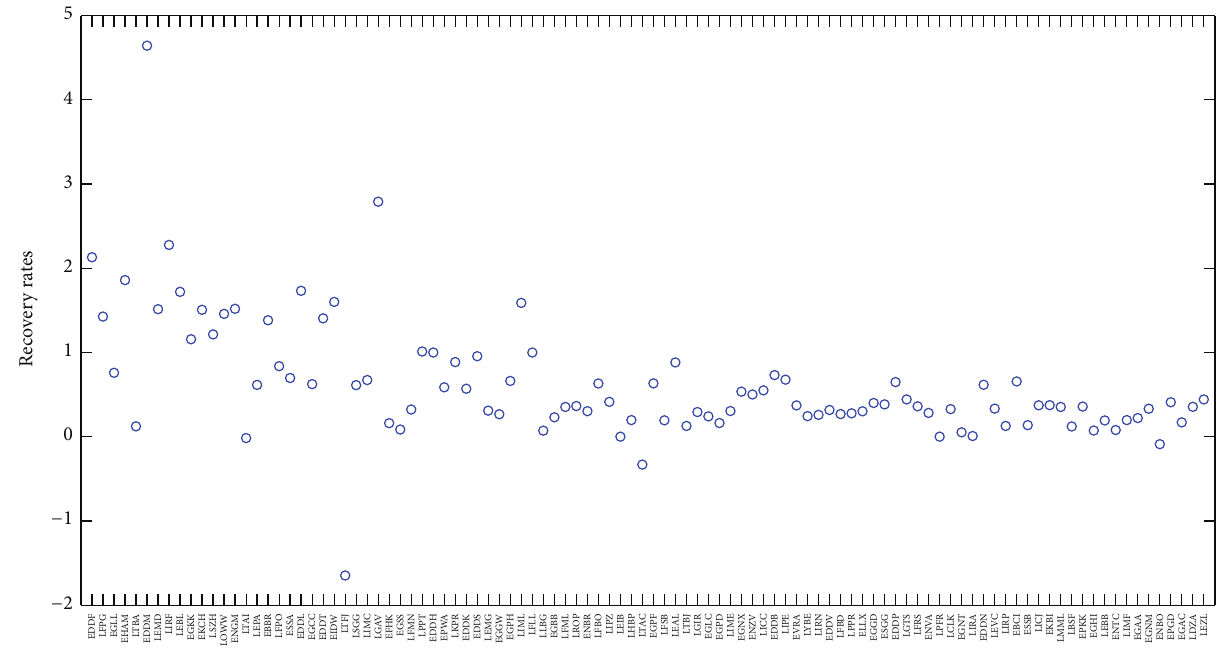
Figure 11: Evaluated nominal recovery rates of European airports through the airport-based epidemic model (analysis has been performed for 2 weeks: March 01–14,